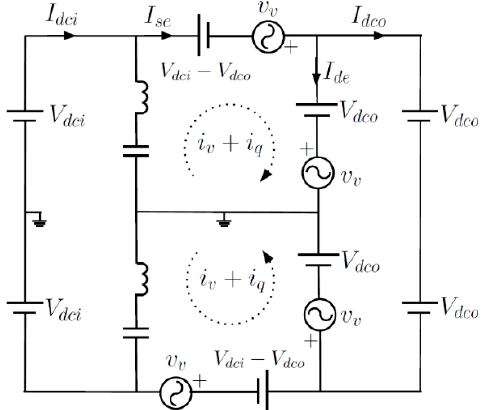
Figure 2. Voltage inserted in each branch.